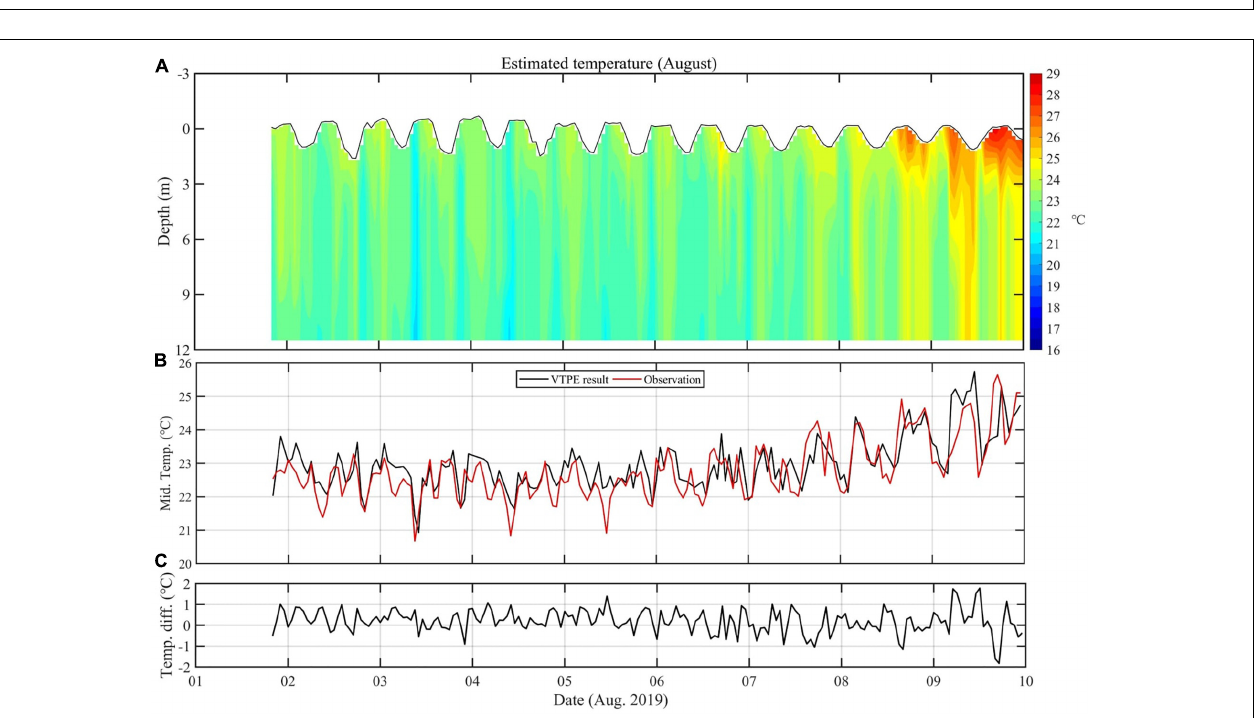
FIGURE 6 | (A) Timeseries of temperature profiles estimated with the VTPE method using the field observation data of February 2019. Note that the SST observation failed for 15 h on February 20. (B) Comparison of the middle-layer temperatures that were estimated and measured in situ at the site between the two CAT stations. (C) Difference between the two timeseries of temperatures shown in (B) .